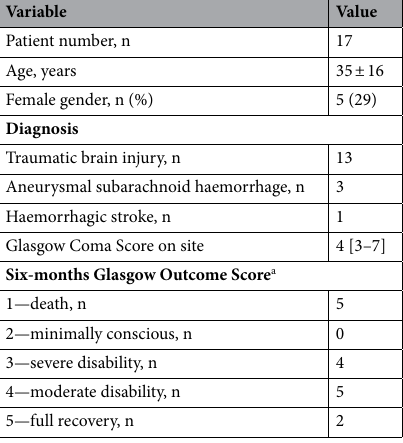
Table 1. Patient characteristics and outcomes. a One patient was lost to six-month follow-up. Data are presented as mean ± standard deviation or median and interquartile range [25th–75th percentiles], unless otherwise